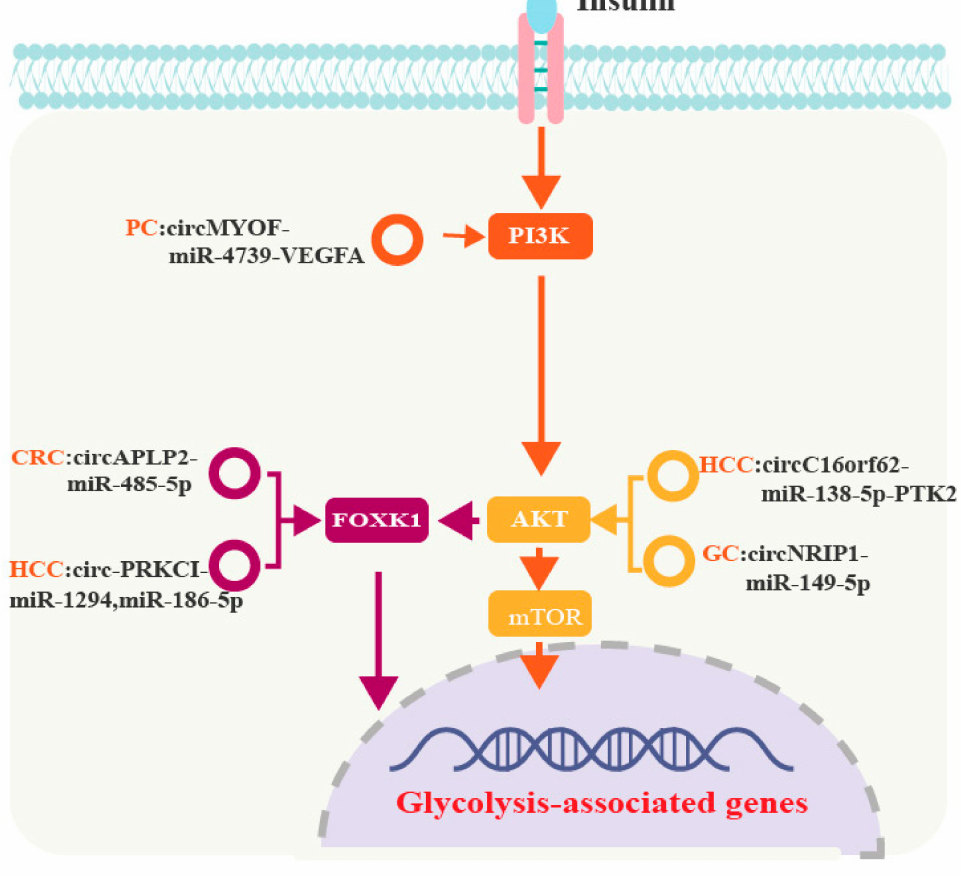
Figure 4. CircRNAs regulate glycolysis via the PI3K/Akt/mTOR and FOXK1 pathways in GI